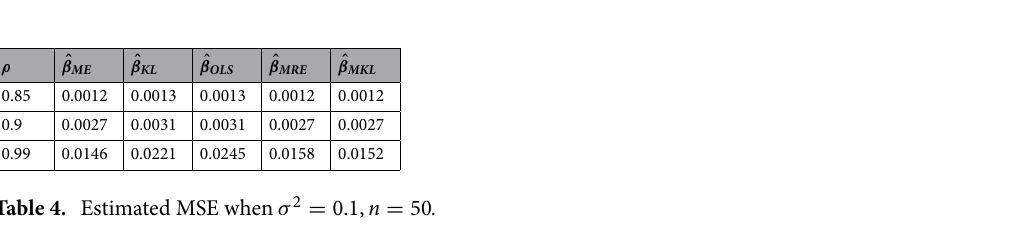
Table 4. Estimated MSE when σ